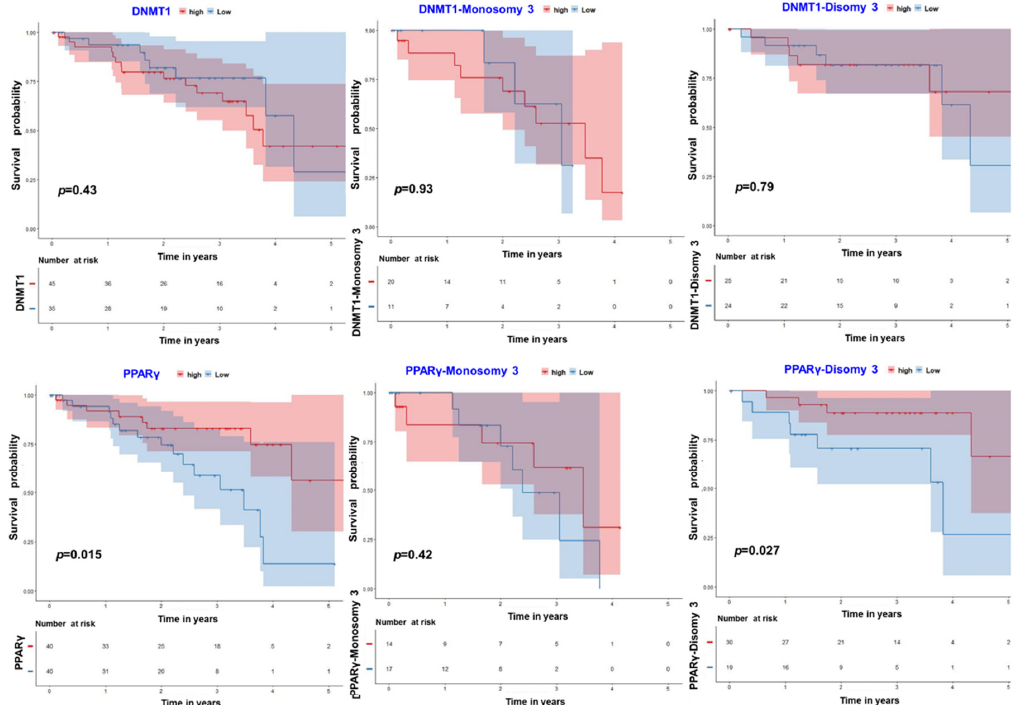
Figure 4. Prognostic analysis of PPAR γ –DNMT1 in the TCGA UM dataset. Classification of 80 cases in TCGA database of UM. The prognostic values of the PPAR γ –DNMT1 genes were analyzed for all cases as well as monosomy 3 and disomy 3 tumors. Overall survival curves were plotted for the cases with high and low expression of the two genes with Kaplan–Meier survival model. Left panels, all cases; middle panels, monosomy 3 class; right panels, disomy 3